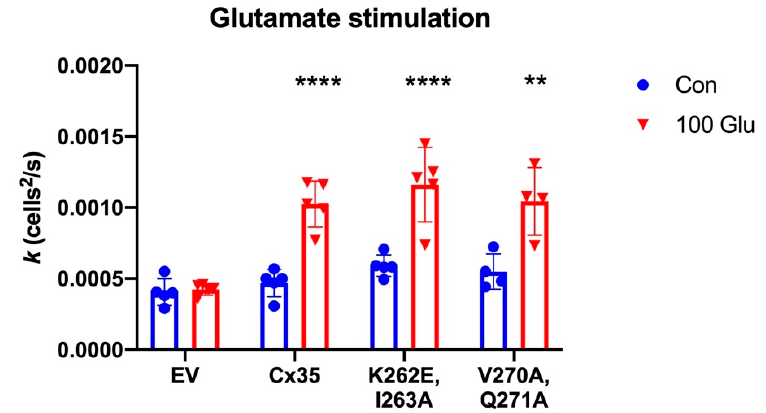
Figure 6. Glutamate-induced potentiation of Cx35 coupling. Diffusion coefficients (k) for Neurobiotin tracer coupling in control Ringer (Con) or Ringer plus 100 µM glutamate (100 Glu) for 20 min. Tracer coupling was not changed in empty vector-transfected HeLa cells (EV) by addition of glutamate. Tracer coupling was significantly increased in wild type Cx35 and the calmodulin binding site mutants K262E, I263A and V270A, Q271A. Bars are mean ± SD; n = 4 to 5 experiments; **** p < 0.0001, ** p < 0.01 vs. control.